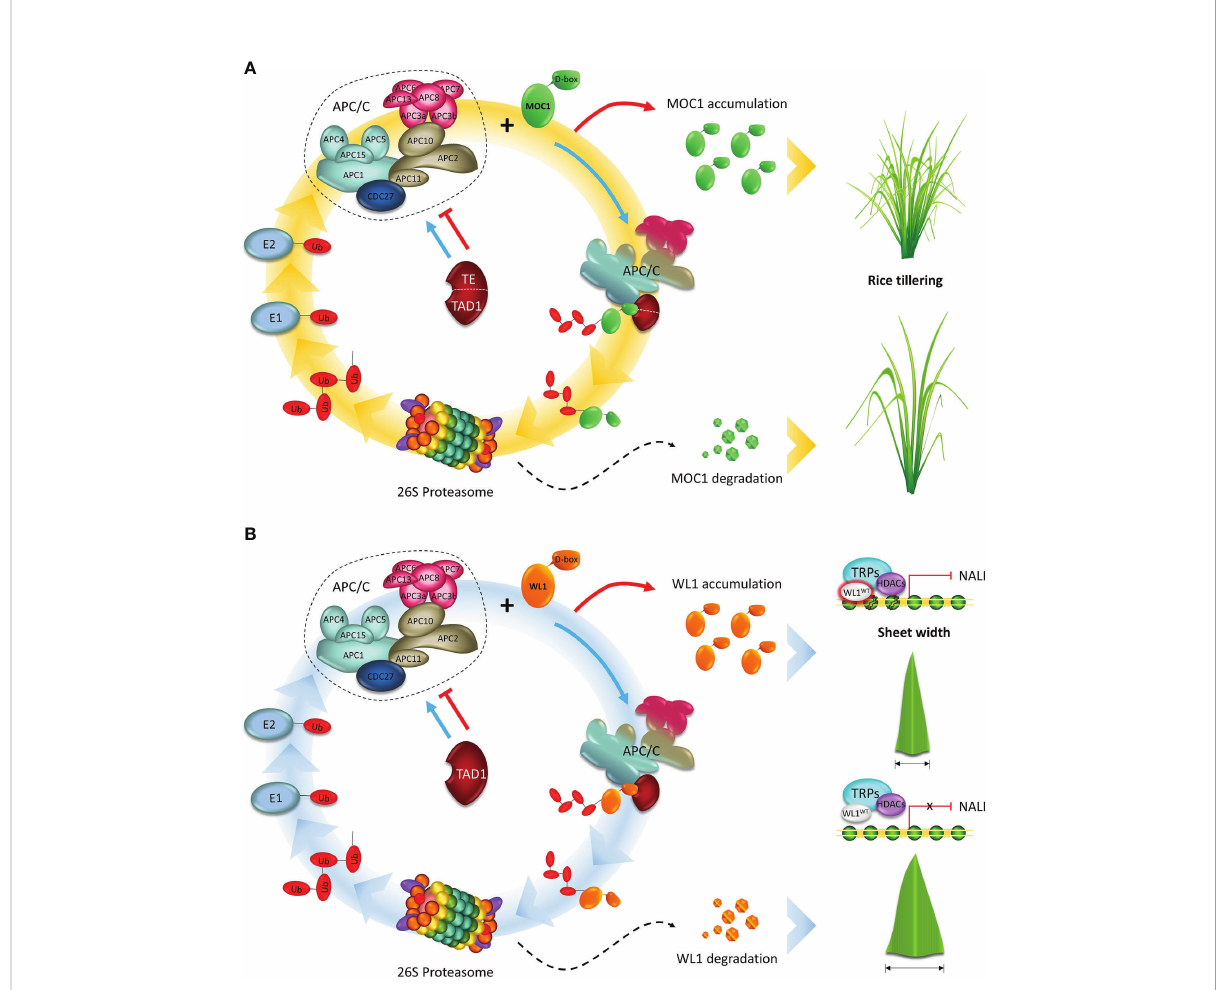
FIGURE 3 APC/C plays an essential role in regulating the development of cereal crops. (A) A model showing the APC/C TE/TAD1 complex-mediated degradation of MOC1. Tiller Enhance (TE)/Tillering and Dwarf 1 (TAD1) act as activators of the Anaphase Promoting Complex/Cyclosome (APC/ C) complex E3 ubiquitin ligase activity and targets MOC1 for degradation through interacting with the D-box by the ubiquitin – 26S proteasome pathway, and consequently represses tillering. (B) A proposed model for APC/C TAD1-WL1-NAL1 module-mediated control of leaf width. TAD1 activates the APC/C E3 ubiquitin ligase activity and targets WIDE-LEAF 1 (WL1) for degradation. WL1 directly binds to the regulatory region of NARROW LEAF 1 (NAL1) and recruits the corepressor TOPLESS-RELATED PROTEIN (TPR) to inhibit NAL1 expression by down-regulating the level of histone acetylation of chromatin, and consequently, decreasing leaf width. Adapted from Lin et al., 2012 and Xu et al.,